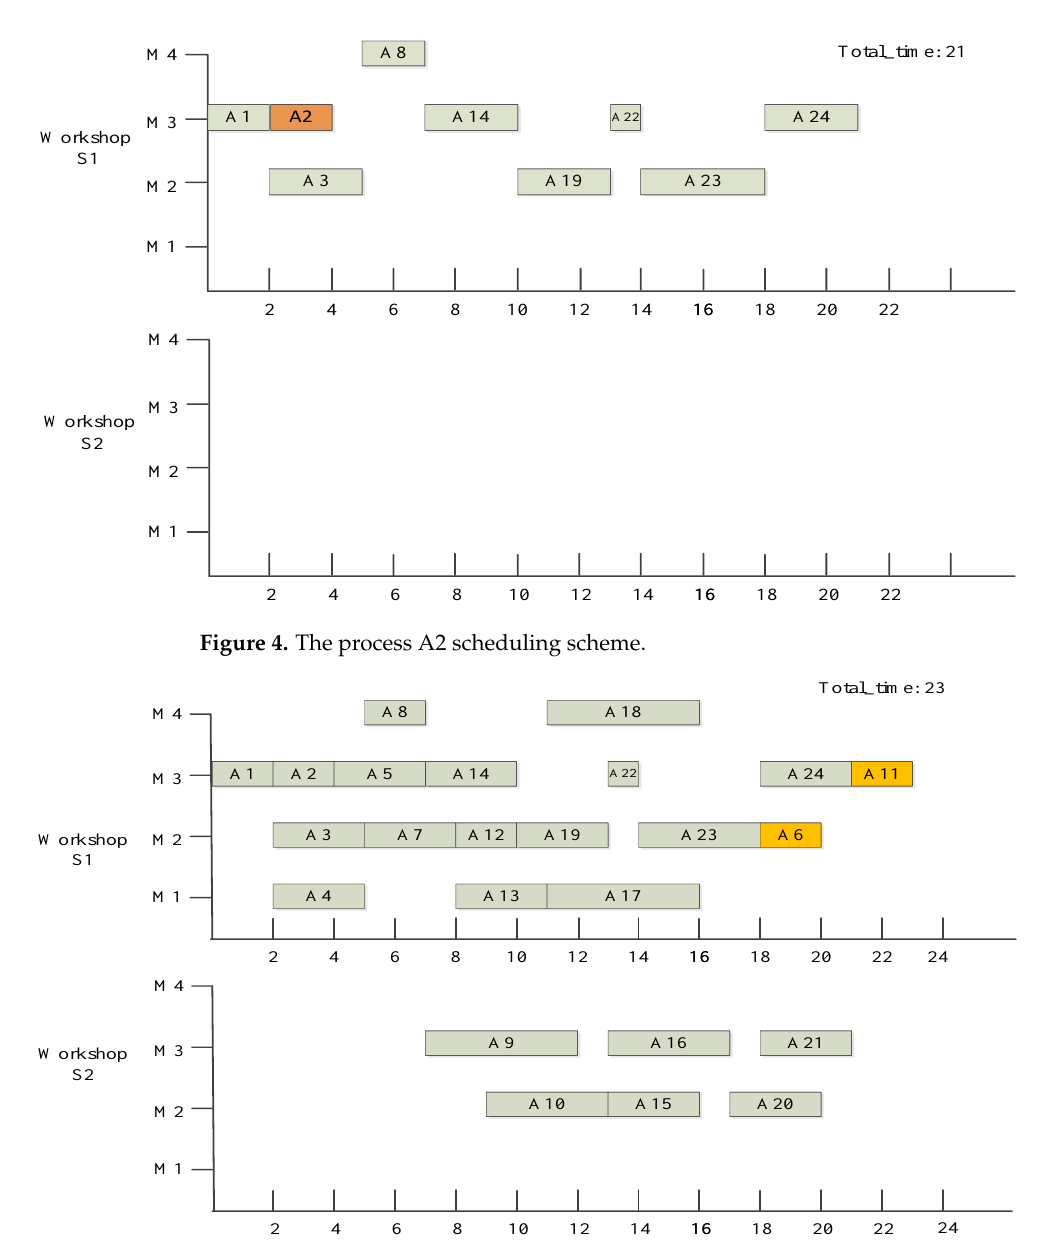
Figure 5. Gantt chart of algorithm scheduling results with time-selected strategy.